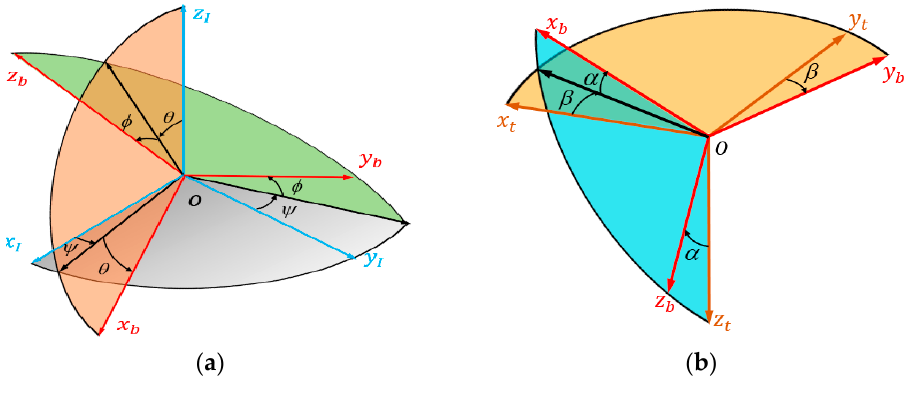
Figure 2. Schematic diagram of the coordinate systems.